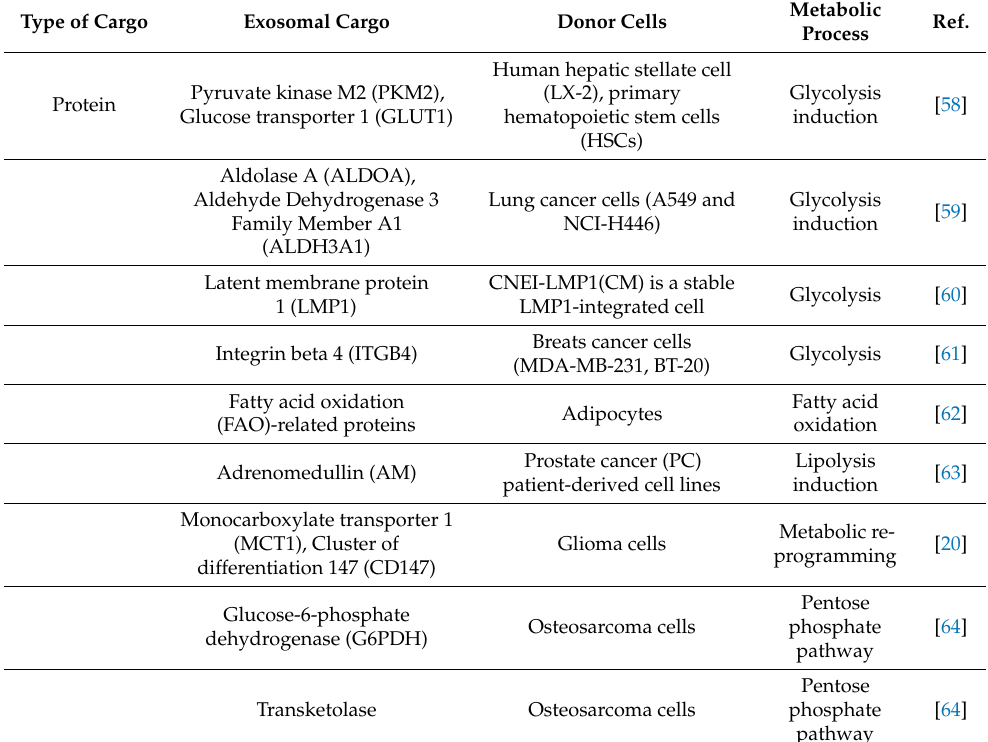
Table 1. Exosomal cargo involved in